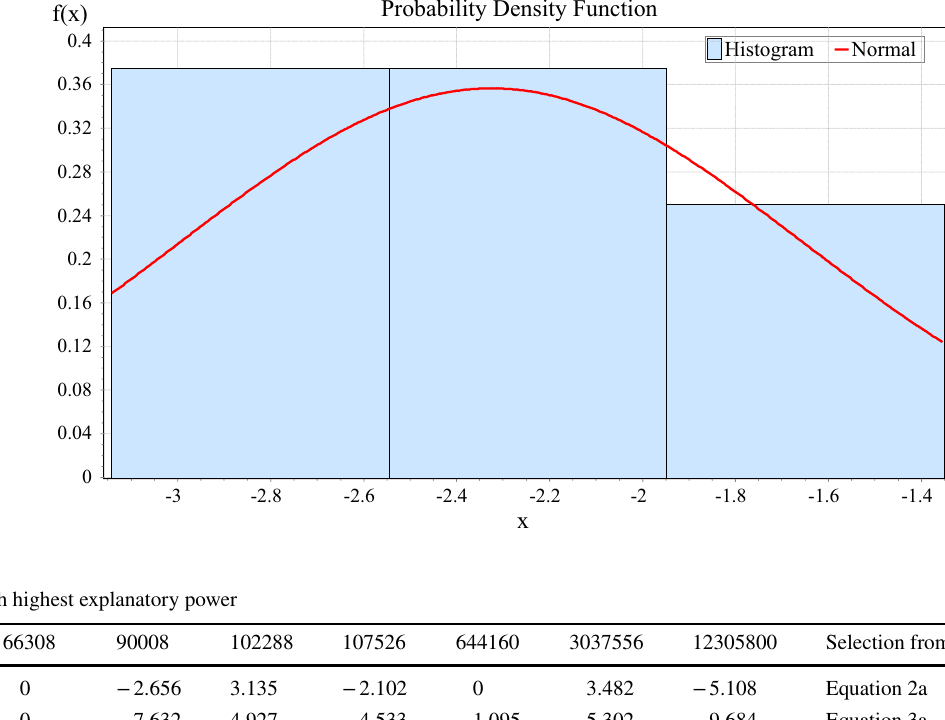
Probability Density Function